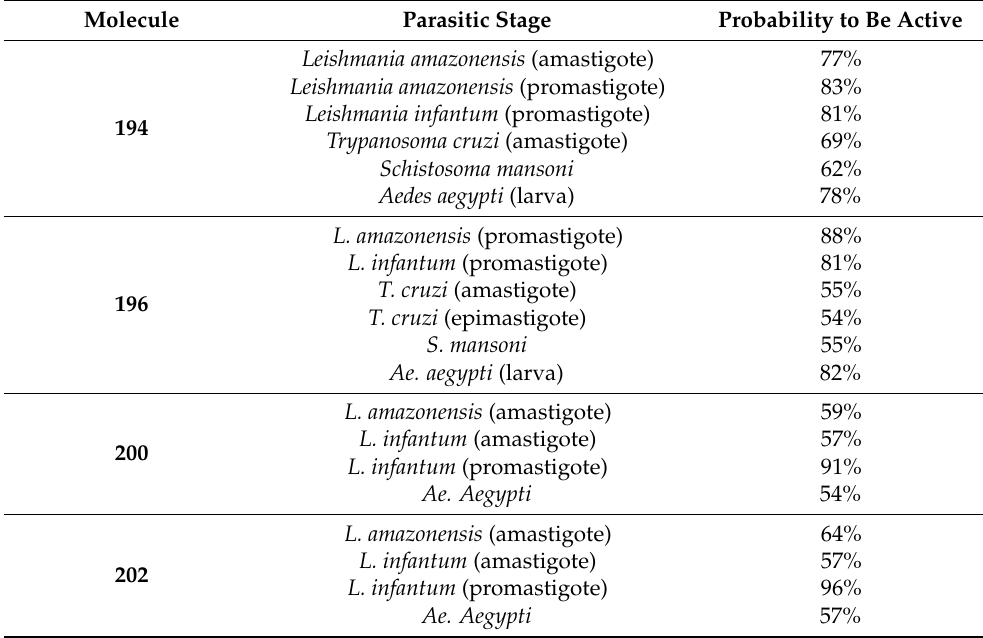
Table 12. Molecules with multitarget potential and their respective active potential probabilities. Molecule Parasitic Stage